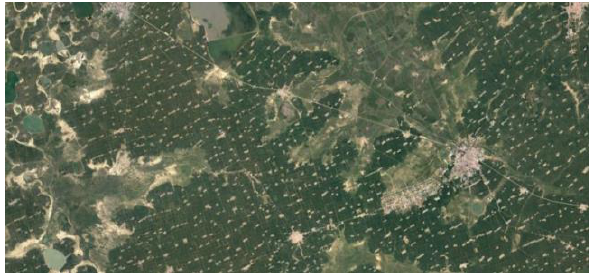
Figure 1. The schematic diagram of the study area